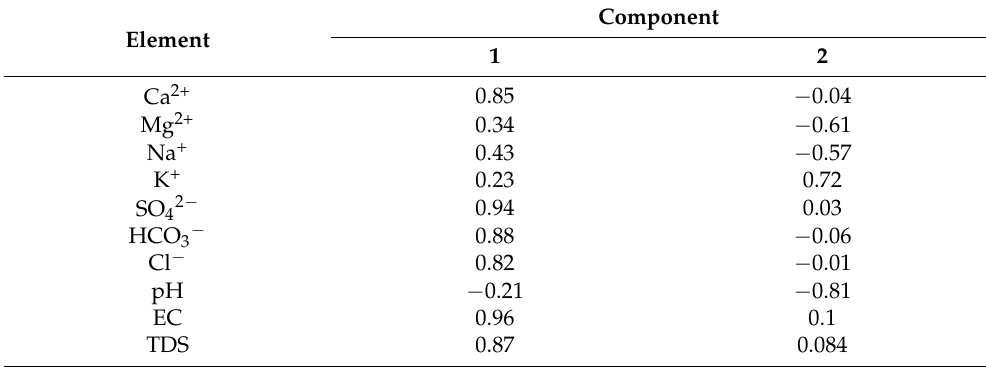
Table 4. The PCA varimax rotation of hydrochemical parameters of the Middle East